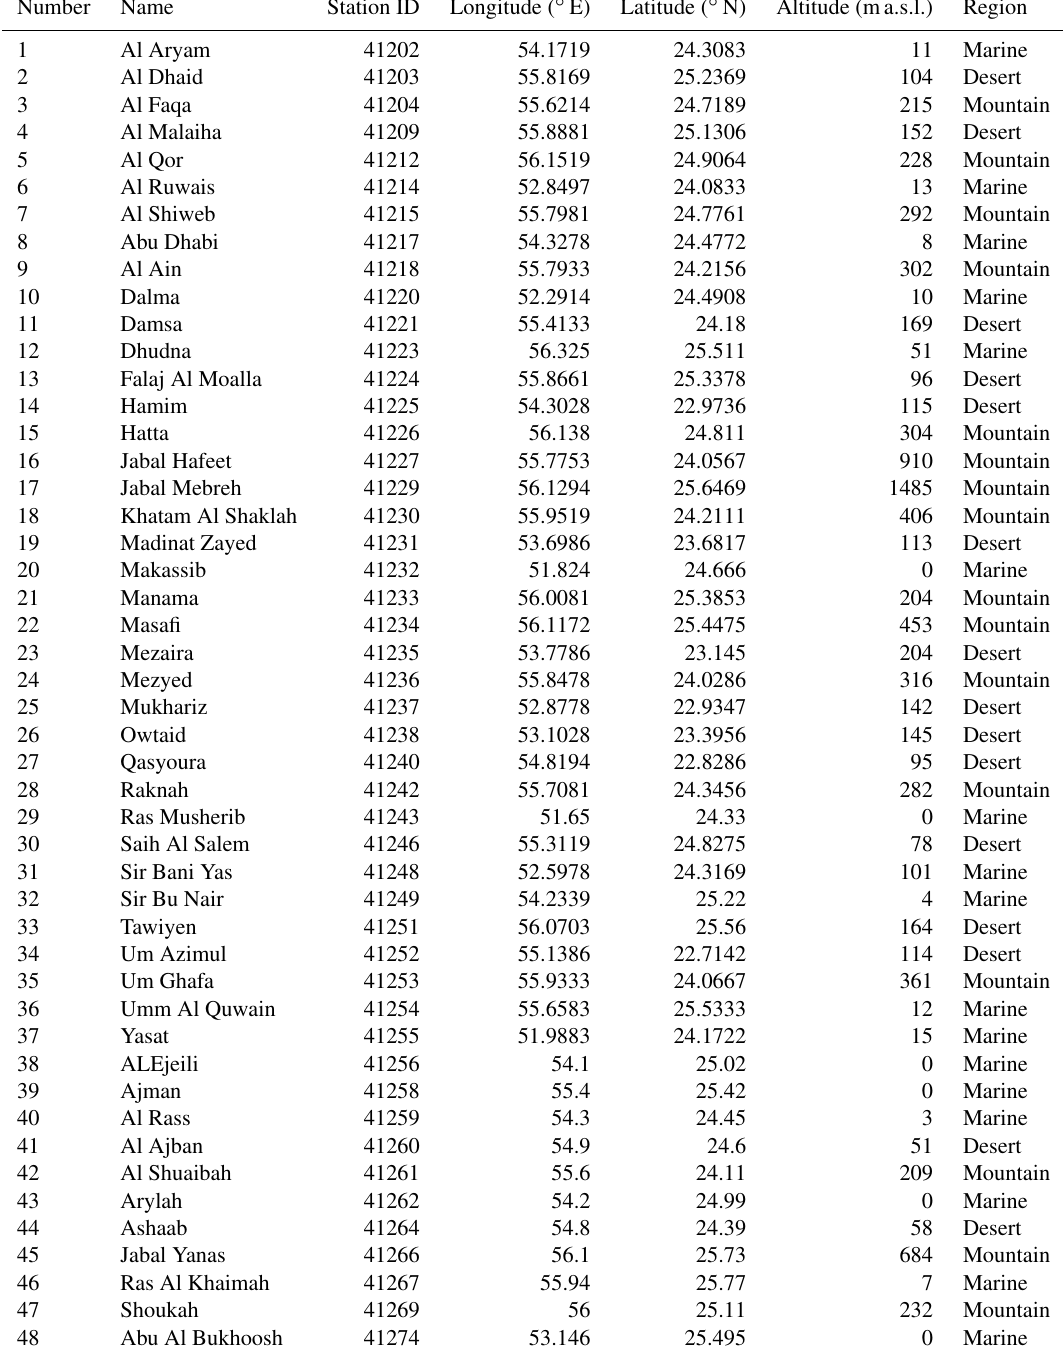
Table A1. List of weather stations used for verification of WRF, including ID, coordinates, altitude, and assigned